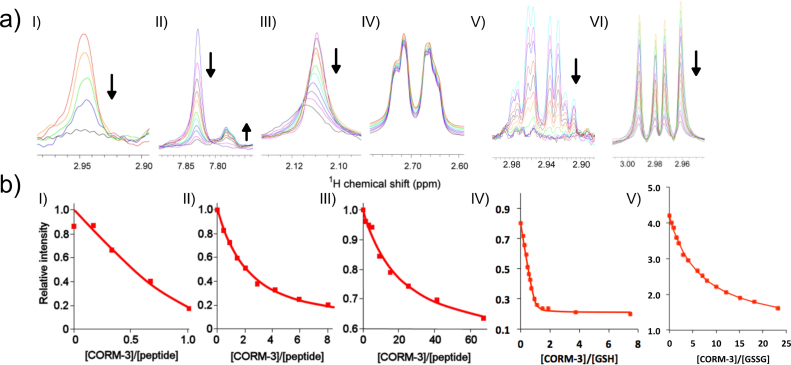
Binding affinities of CORM-3 to selected amino acids or glutathione as determined by 1H NMR. (a) 1H NMR spectra of: (I) Cys Hβ of A3CA3 peptide titrated with 0, 0.17, 0.33, 0.67 and 1.0 equivalents CORM-3; (II) His aromatic proton region of A3HA3 with 0, 0.43, 0.86, 1.4, 2.0, 2.9, 4.2, 5.9, 8.1, 11.5 and 18 equivalents CORM-3; (III) Met Hε region of A3MA3 with 0, 1, 3, 5, 9, 15, 24, 41, 67 and 134 equivalents CORM-3; (IV) Asp Hβ region of A3DA3 with 0, 0.33, 1.0, 1.5, 3.2, 6.5, 13 and 20 equivalents CORM-3; (V) GSH titrated with 0, 0.25, 0.375, 0.5, 0.625, 0.75, 0.875, 1.0, 1.25, 1.5, 2.0, 2.5 and 5.0 equivalents CORM-3; and (VI) GSSG titrated with 0, 0.5, 1, 1.5, 2, 3, 4, 6, 7, 8, 10, 12, 15, 18 and 23 equivalents CORM-3. Titrations were performed in 30 mM KPi buffer, with pH adjusted to ~ 7 – 7.6 where required. Arrows indicate the direction of signal intensities following increasing addition of CORM-3. (b) Binding curves of the decrease in intensity of 1H NMR signals in (a) corresponding to: Cys (I), His (II), Met (III), GSH (IV) and GSSG (V) upon increasing additions of CORM-3. 3. The estimated Kd of CORM-3 to each peptide was determined to be: 5 ± 3 μM for Cys, 800 ± 100 μM for His, 4700 μM for Met, 4 ± 2 μM for GSH and 9190 ± 1000 μM for GSSG.